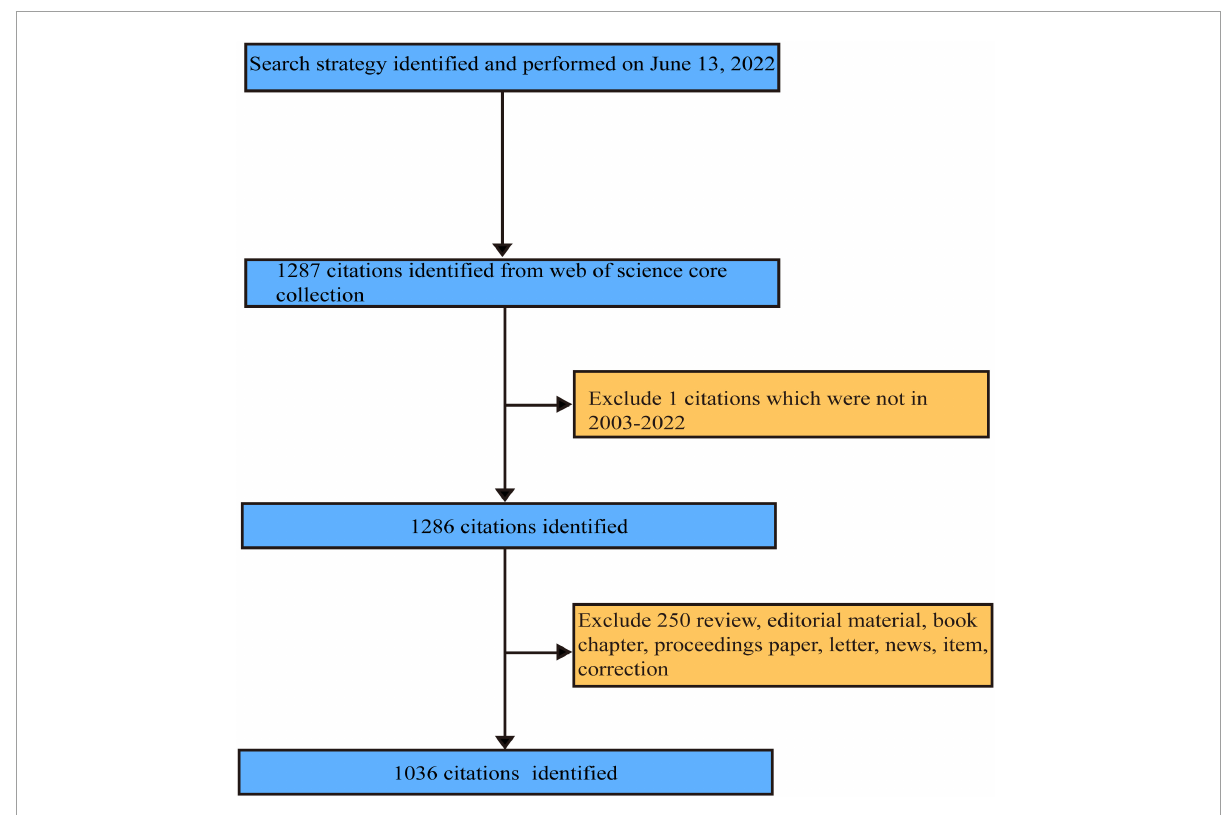
FIGURE1 The flow diagram of literature selection according to the inclusion and exclusion criteria.